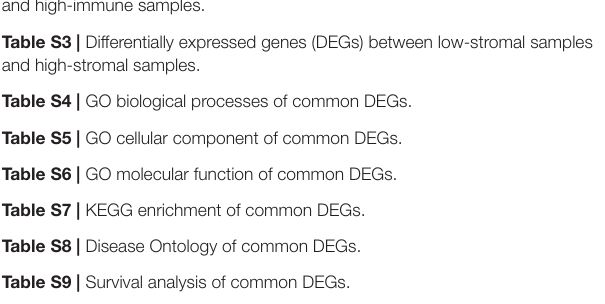
Figure S5 | Forest plot summary of analyses of OS. Univariable (A) and multivariable analyses (B) of the stromal score, immune score, C7, age, laterality,